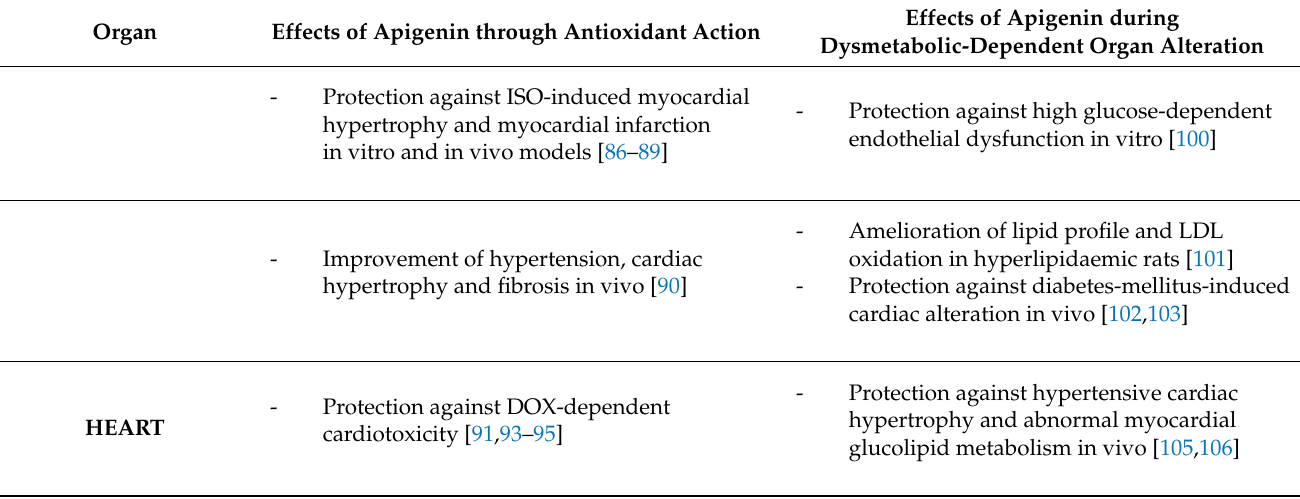
Table 3. Cardioprotective, neuroprotective and renoprotective effects of apigenin following different toxic stimuli and during dysmetabolic-induced organ